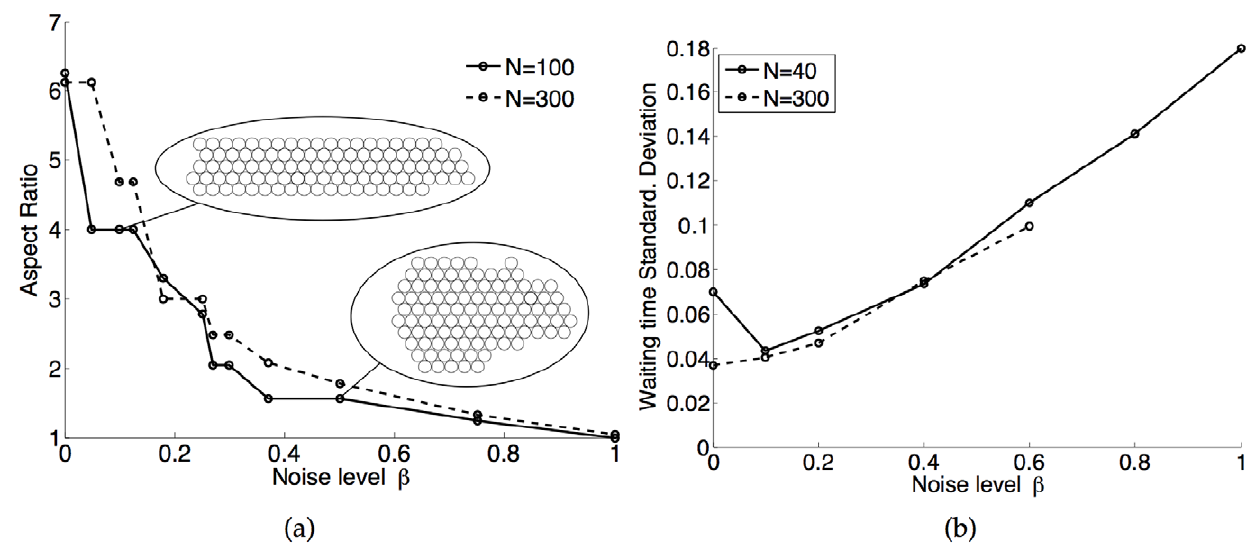
Figure 5. Influence of random variations on huddle shape and heat loss distribution. a) Aspect ratio of huddles of N =100 (solid line) and N =300 (dashed line) penguins for various values of the magnitude of the random perturbation added to the perceived heat loss, b . b) Dependence of the standard deviation of the normalized waiting time on b . Other parameters are R ~ 4 and Pe ~ 100 for both figures.